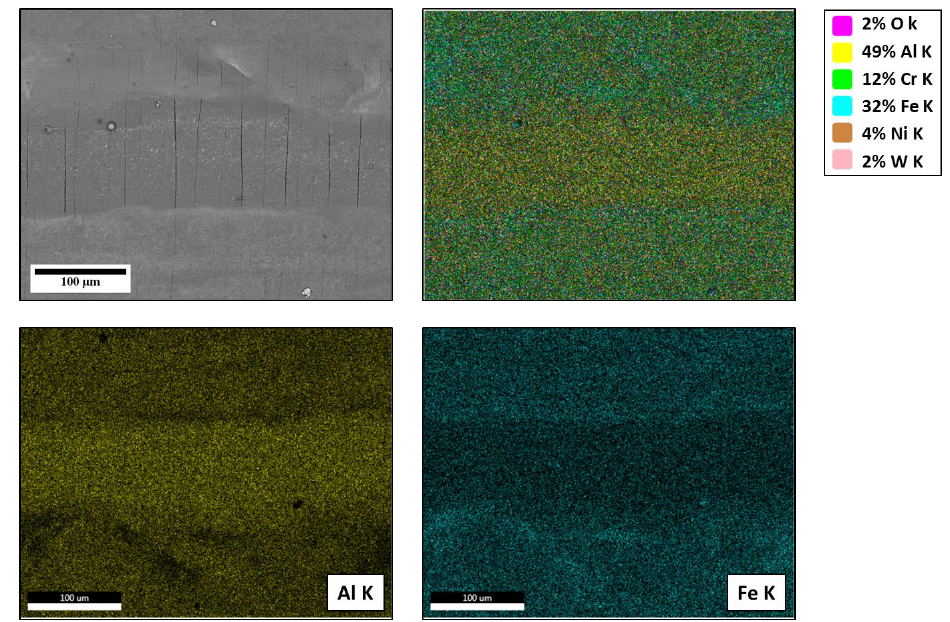
Figure 18. Scanning electron microscope (SEM) mapping of the center zone of friction drilled joint under normal condition.